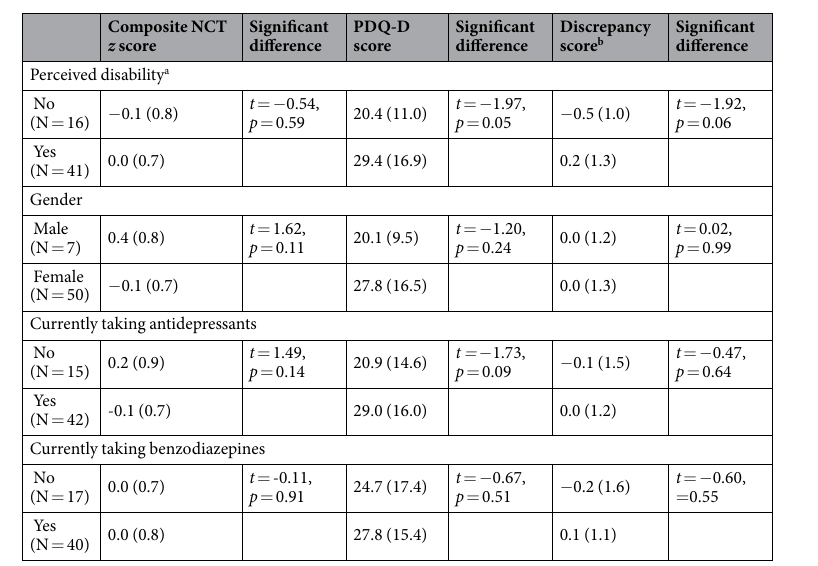
Table 2. Socio-demographic and clinical characteristics correlated with objective cognitive function ( z scores of 4 neurocognitive tests) and subjective cognitive function (PDQ-D score) in 57 patients with MDD. a Composite NCT z score subtracted by corresponding reversed PDQ-D z score. PDQ-D = Perceived Deficits Questionnaire for Depression; PHQ-9 = Patient Health Questionnaire.